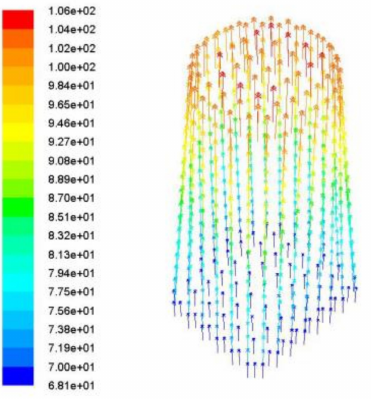
Figure 7. Simulation of ϕ 1.8 × 10 2 mm airduct.